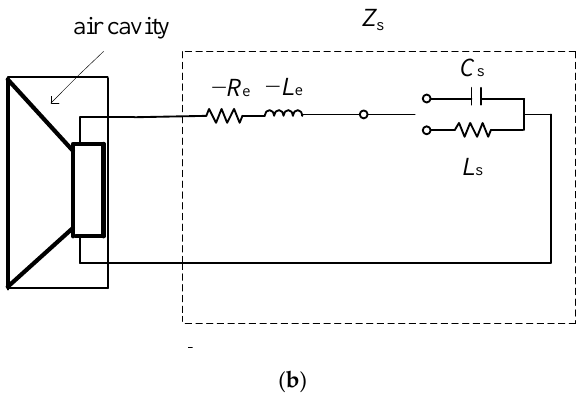
Figure 1. ( a ) A schematic of the shunted loudspeaker array set at the end of an impedance duct; ( b ) the equivalent circuit of a shunt loudspeaker unit.